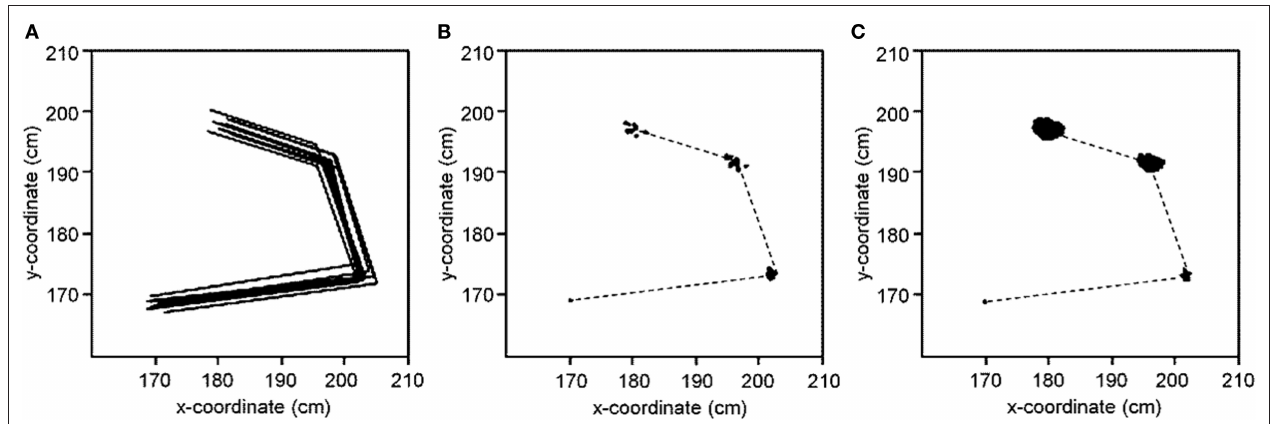
dispersion of the fingertip after introduction of a shoulder-fixed coordinate system (bivariate variable error of 10 data points), and (C) the potential dispersion of the fingertip, calculated through a complete permutation of the joint coordinates (bivariate variable error of 1000 data